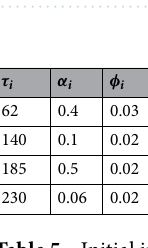
Table 4. Initial state populations used for pandemic modeling.